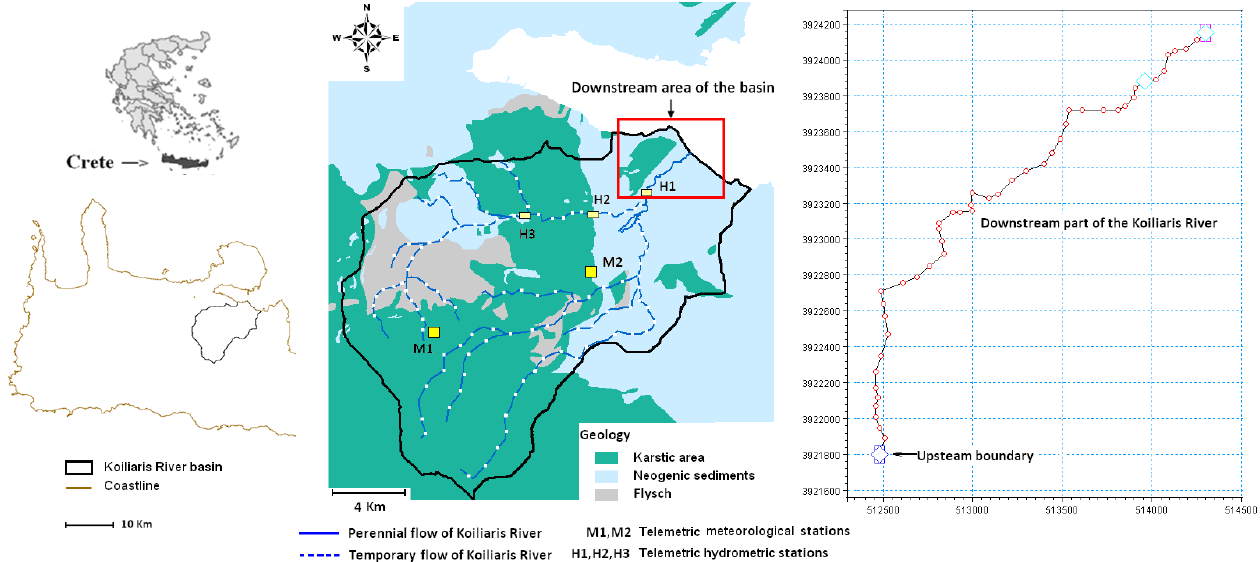
Fig. 1. Geology of the Koiliaris River basin and location of the upstream boundary of the model area.